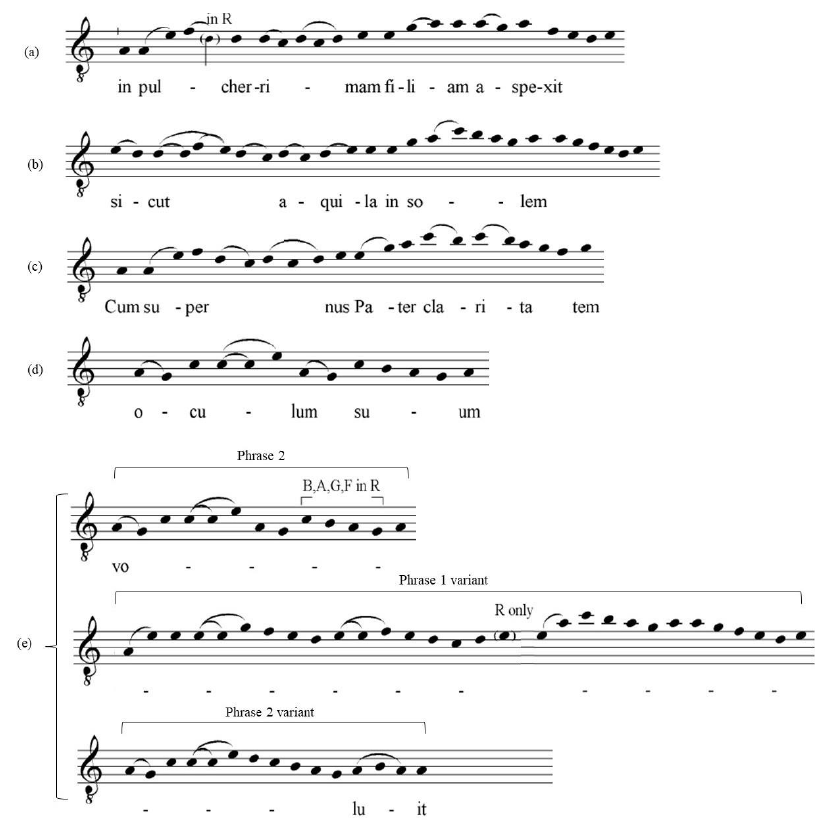
Figure 3. Phrases from O tu suavissima virga: ( a ) Phrase 1 from line 4. ( b ) Phrase 1 variant from line 5. ( c ) Phrase 1 variant from line 7. ( d ) Phrase 2 from line 6. ( e ) End of repetendum. Adapted from the transcription of Beverly R. Lomer/International Society of Hildegard von Bingen